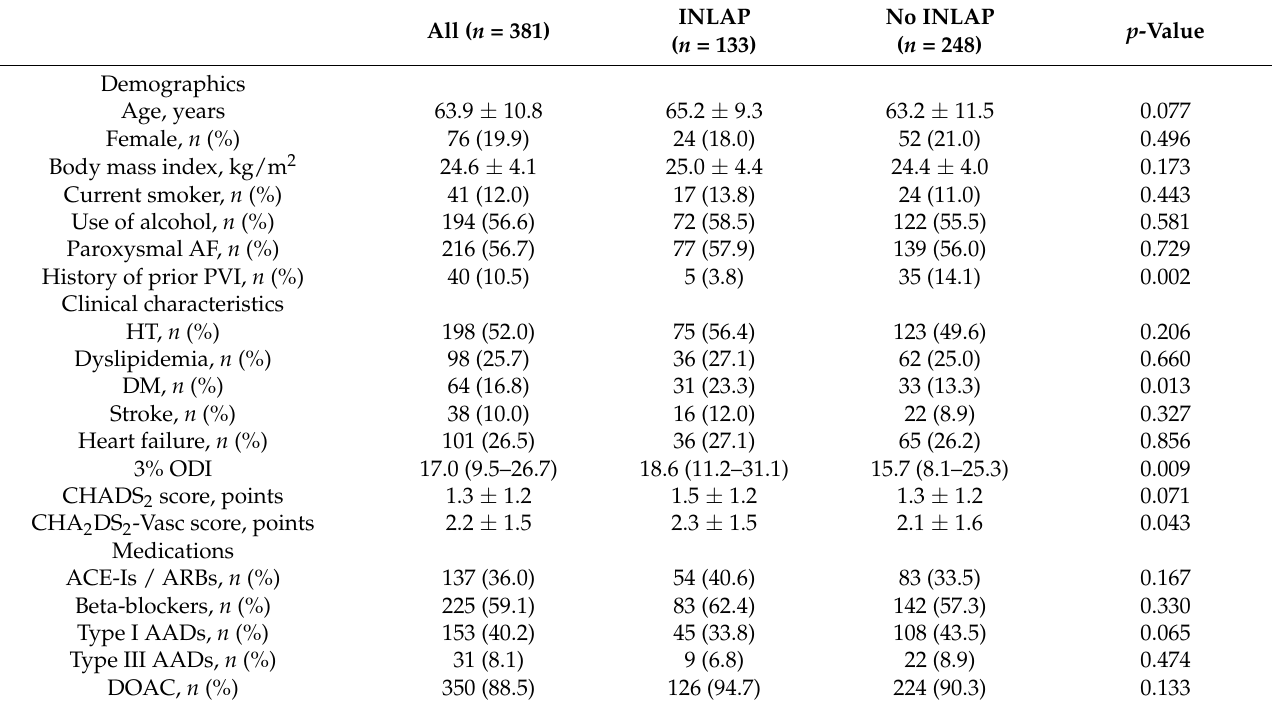
Table 1. Demographic and baseline characteristics in patients with and without inspiration-induced negative left atrial